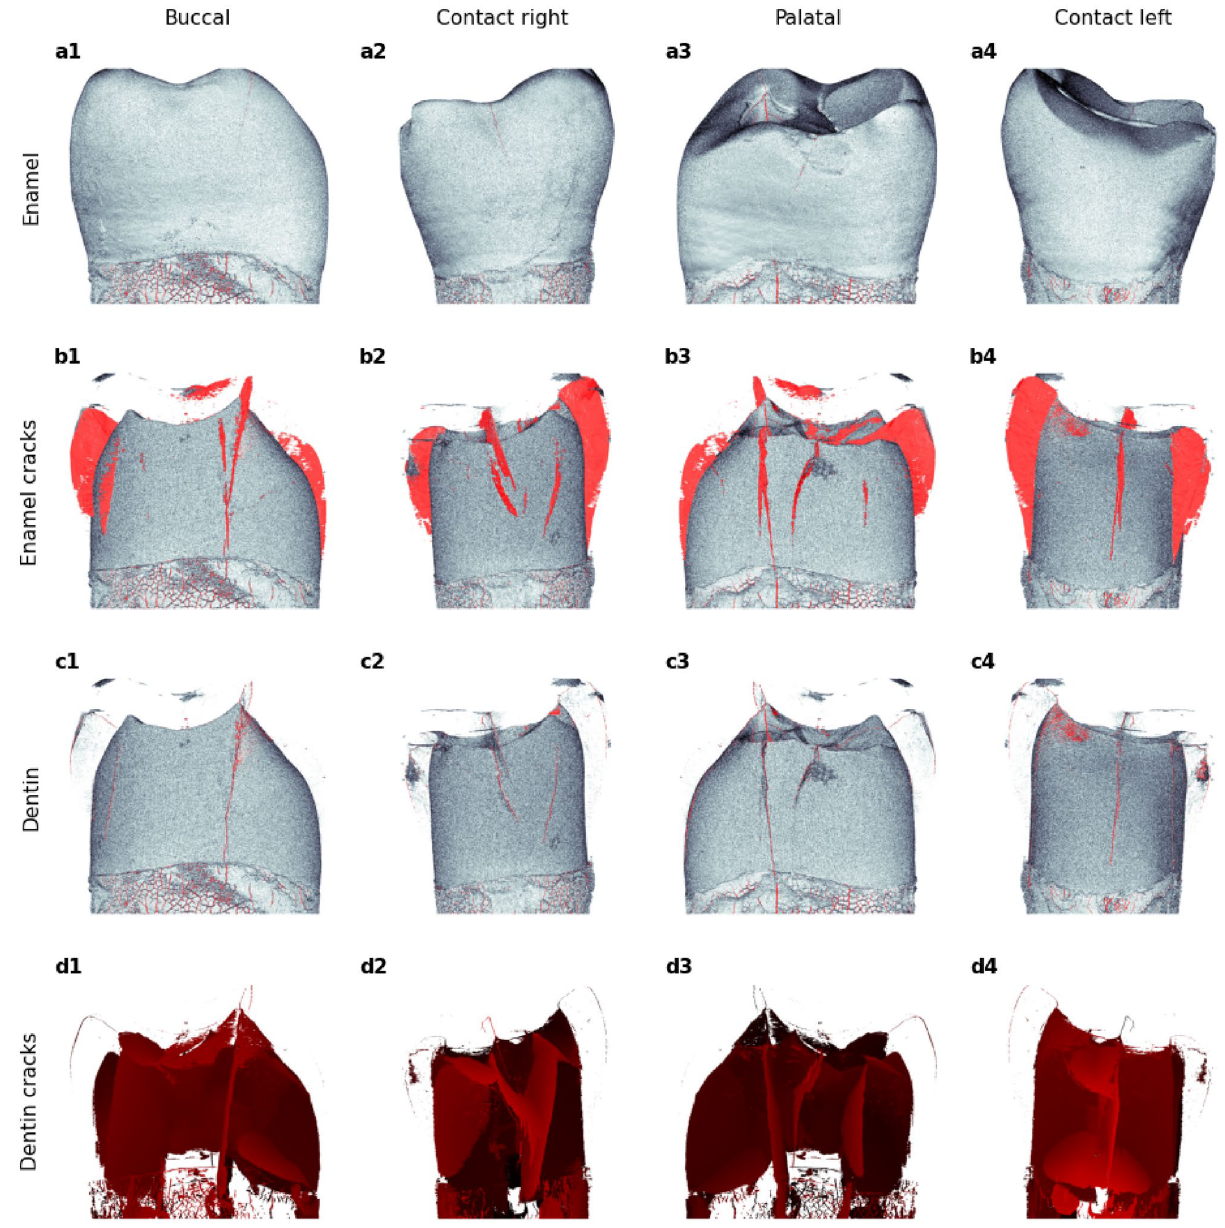
Figure 6. Views of four surfaces (buccal, contact right, palatal, and contact left) of the tooth. ( a1 – a4 ) Enamel surface and cracks (red), ( b1 – b4 ) with the enamel removed, dentin surface is visible with cracks within the enamel volume (red), ( c1 – c4 ) cracks on the dentin surface, and ( d1 – d4 ) cracks within the dentin volume shaded as distance along the line of sight (lighter red indicates distance closer / darker—further from the